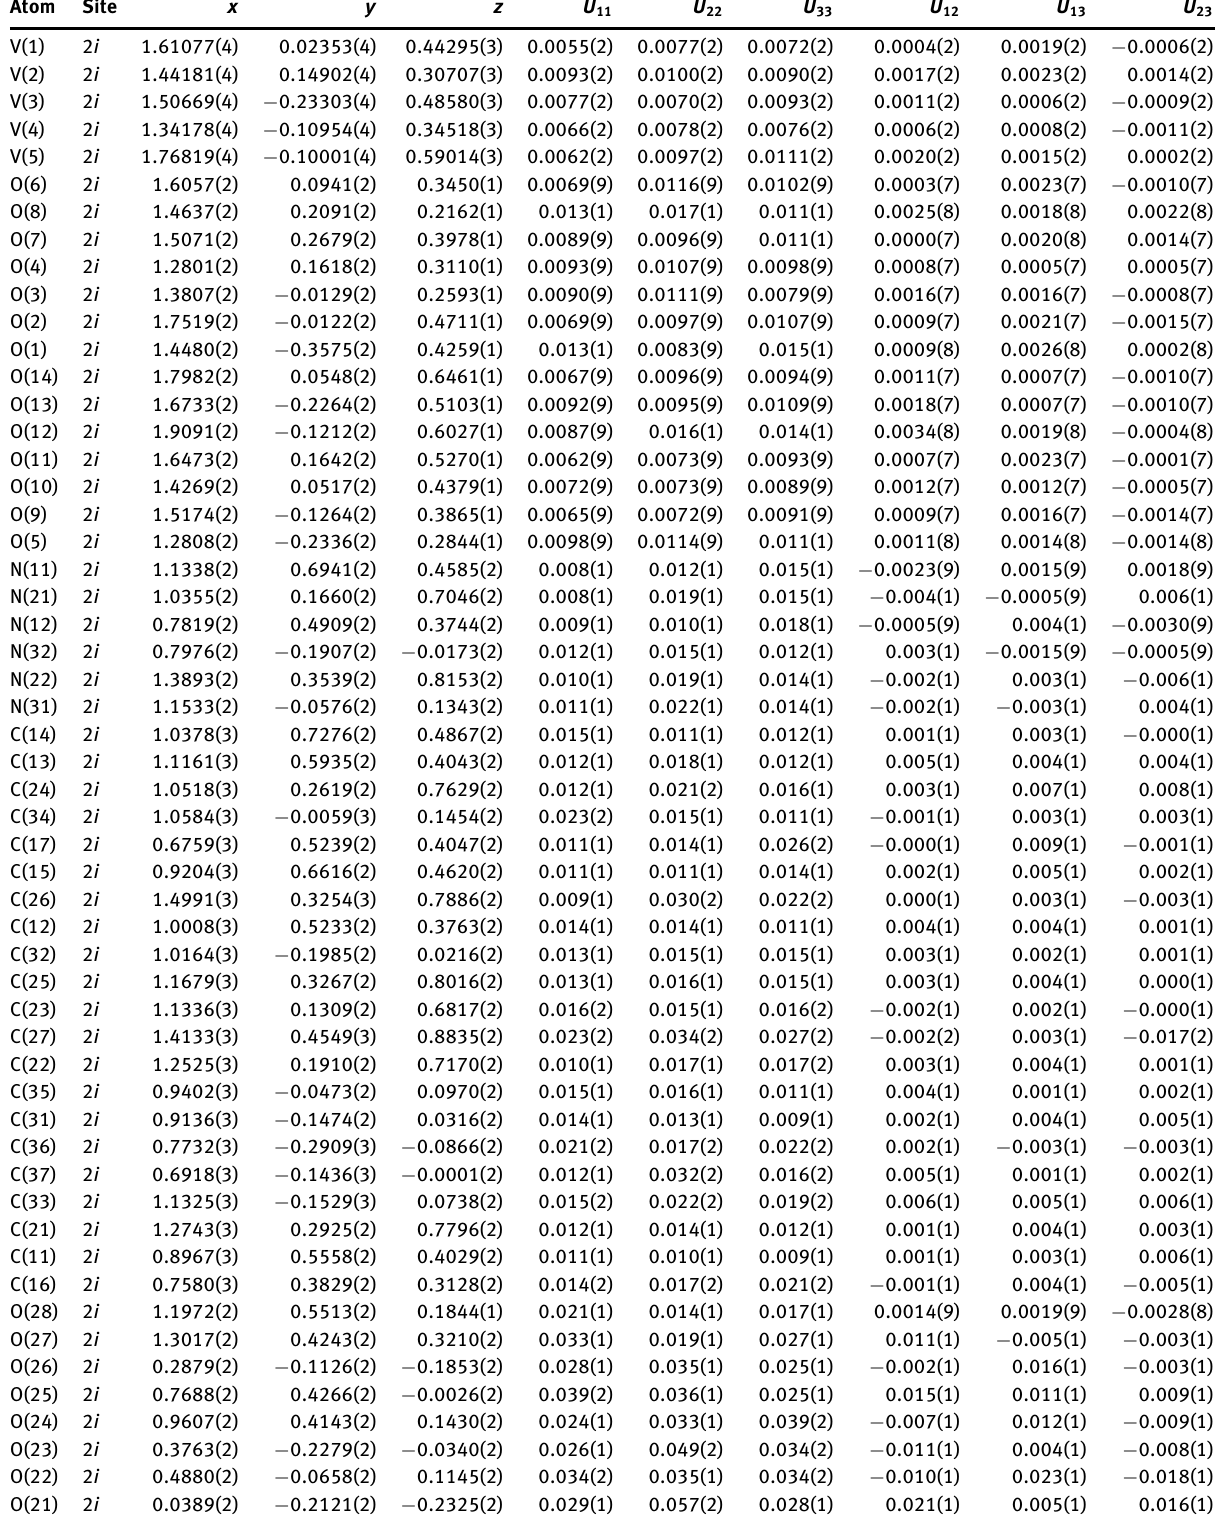
Table 3: Atomic coordinates and displacement parameters (in Å 2